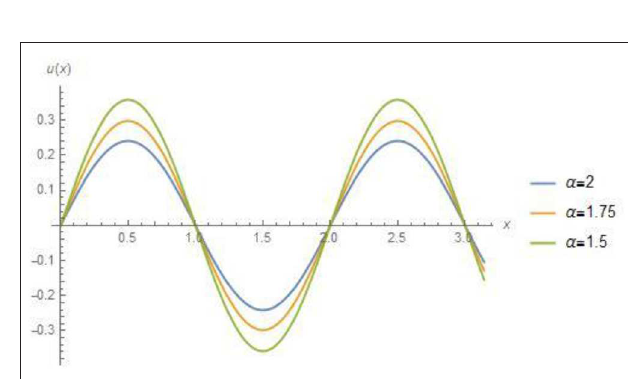
FIGURE 1 | Surface of Exact solution for TFPPDE (20) with α